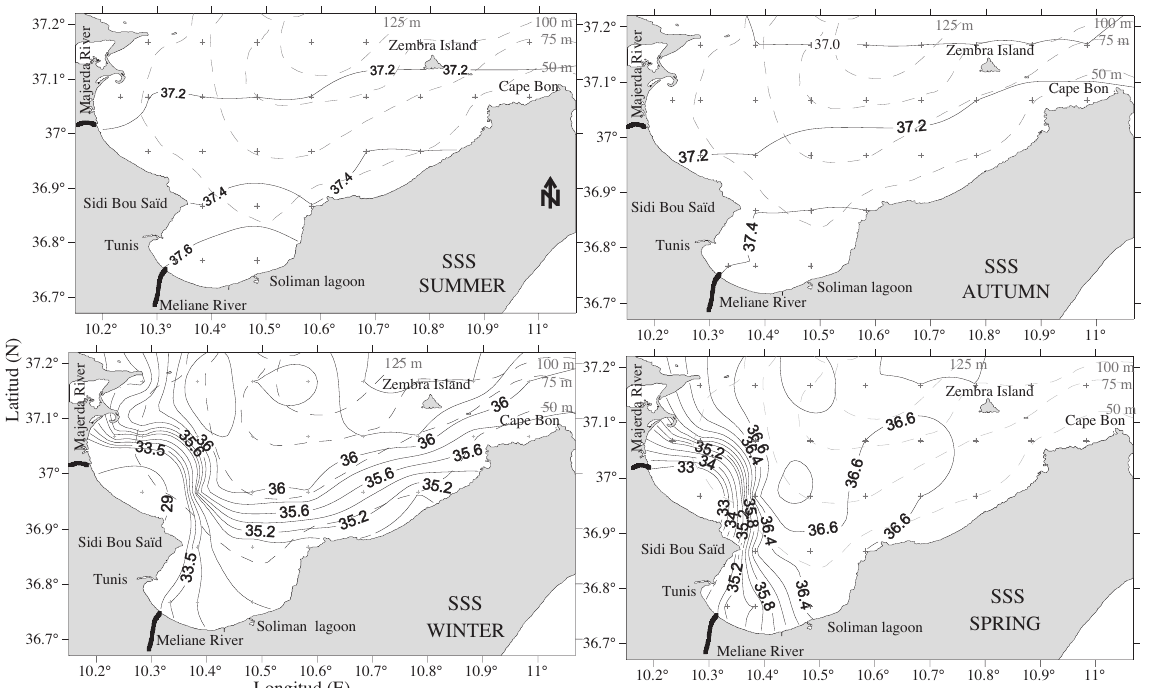
F IG . 3. – Seasonal spatial distribution of sea surface salinity in the Gulf of